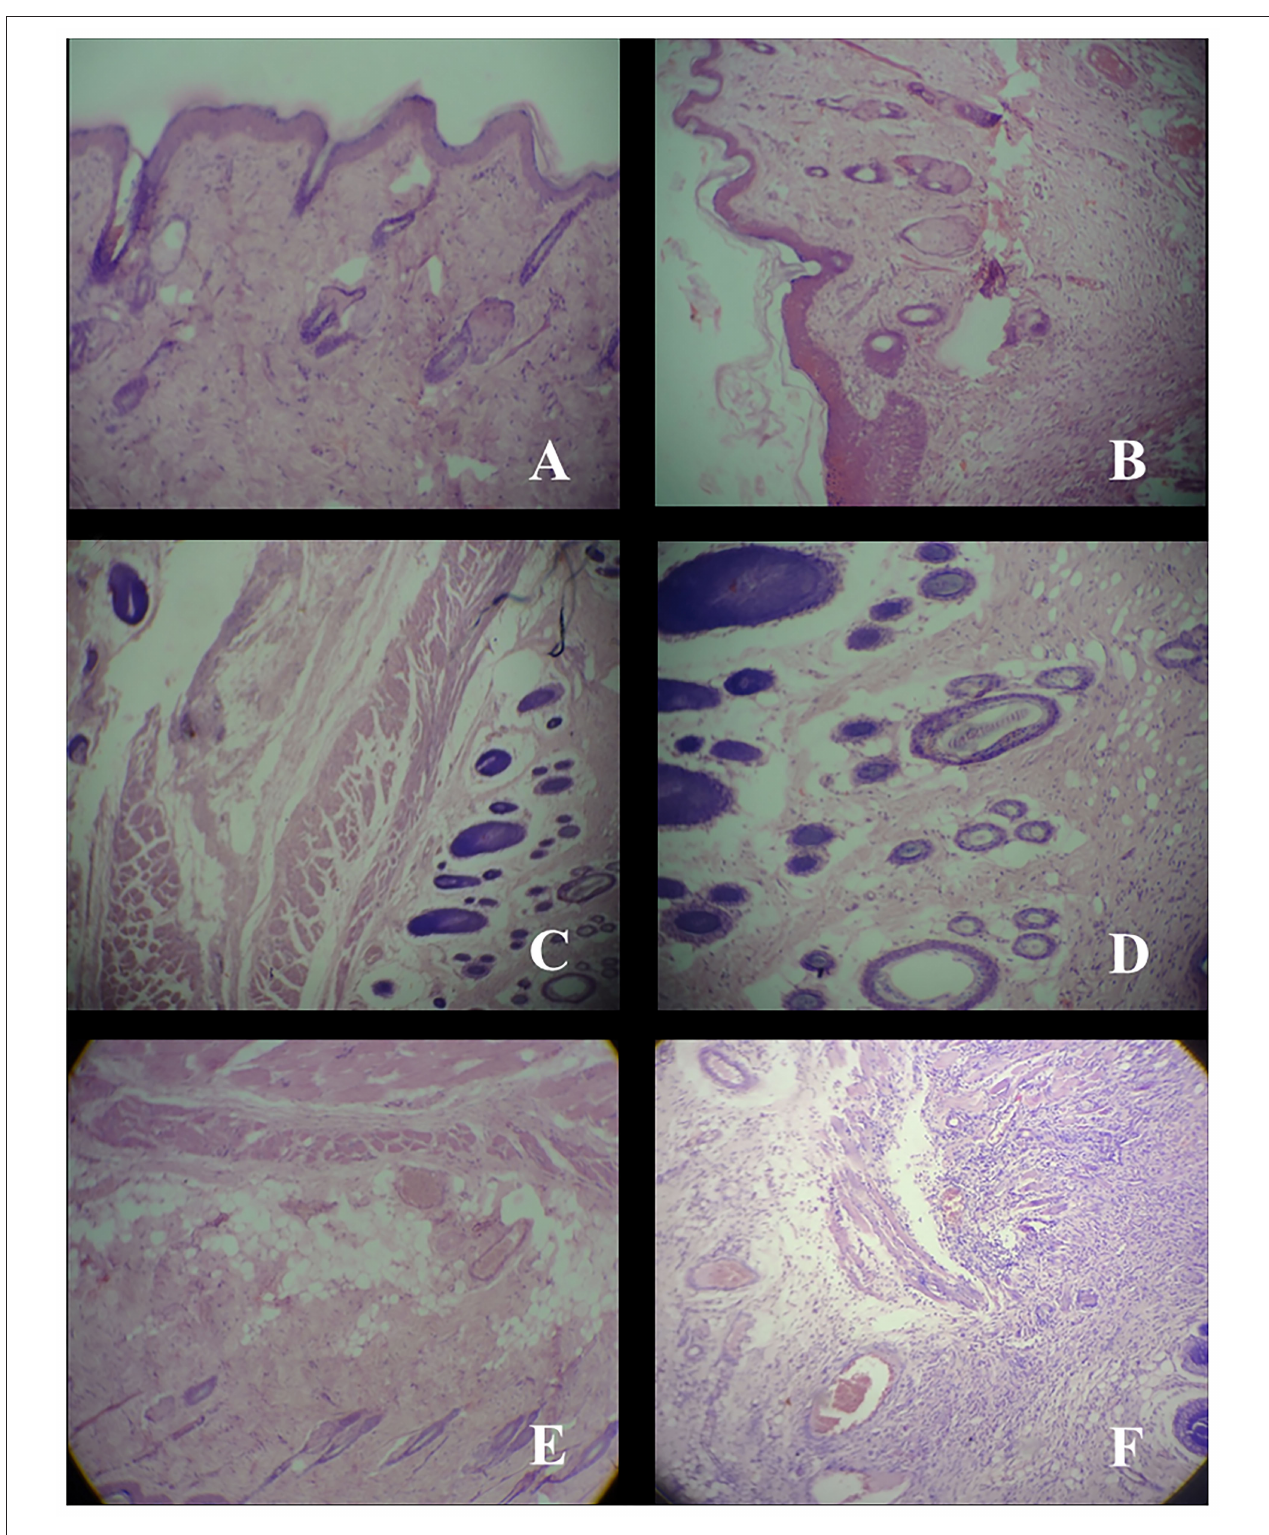
FIGURE 3 | Histology of skin tissue taken from healed area after wound-healing study at a resolution of 40 × . (A) Group A; Thin epiderm, no inflammatory. (B) Group B; Thin epiderm, collagen. (C) Group C; Thick collagen, regenerating hair follicle. (D) Group D; Cellular infiltration, regenerating hair follicle. (E) Group E; Edema, congestion, persistent inflammatory cell. (F) Group F; Congestion, inflammatory